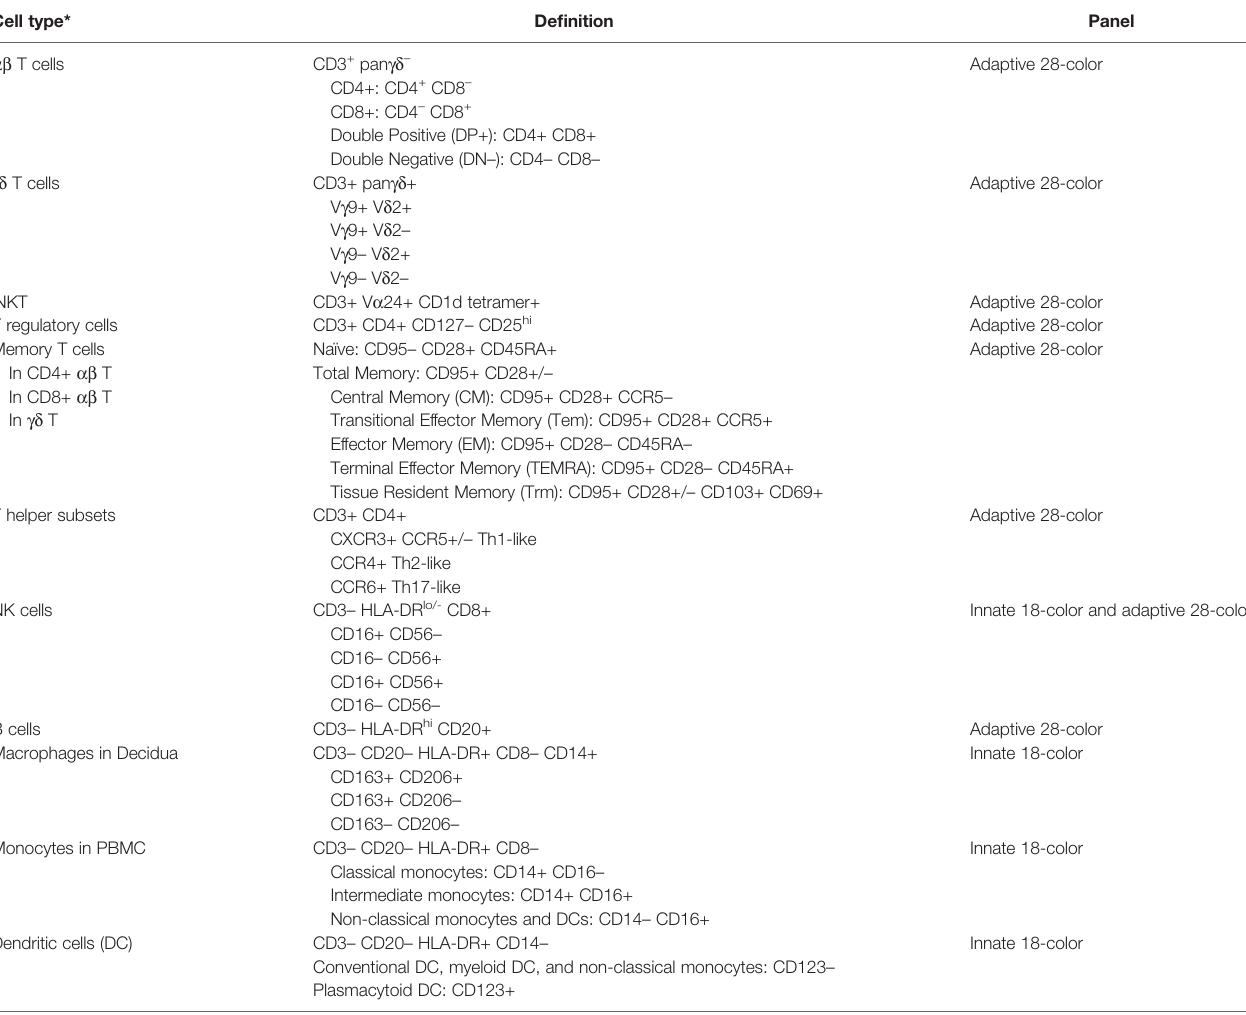
TABLE 2 | Flow cytometric de fi nition of cell types. Cell